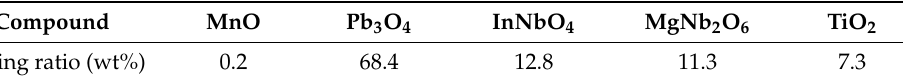
Table 1. Mixing ratios of oxides used for fed ceramics.